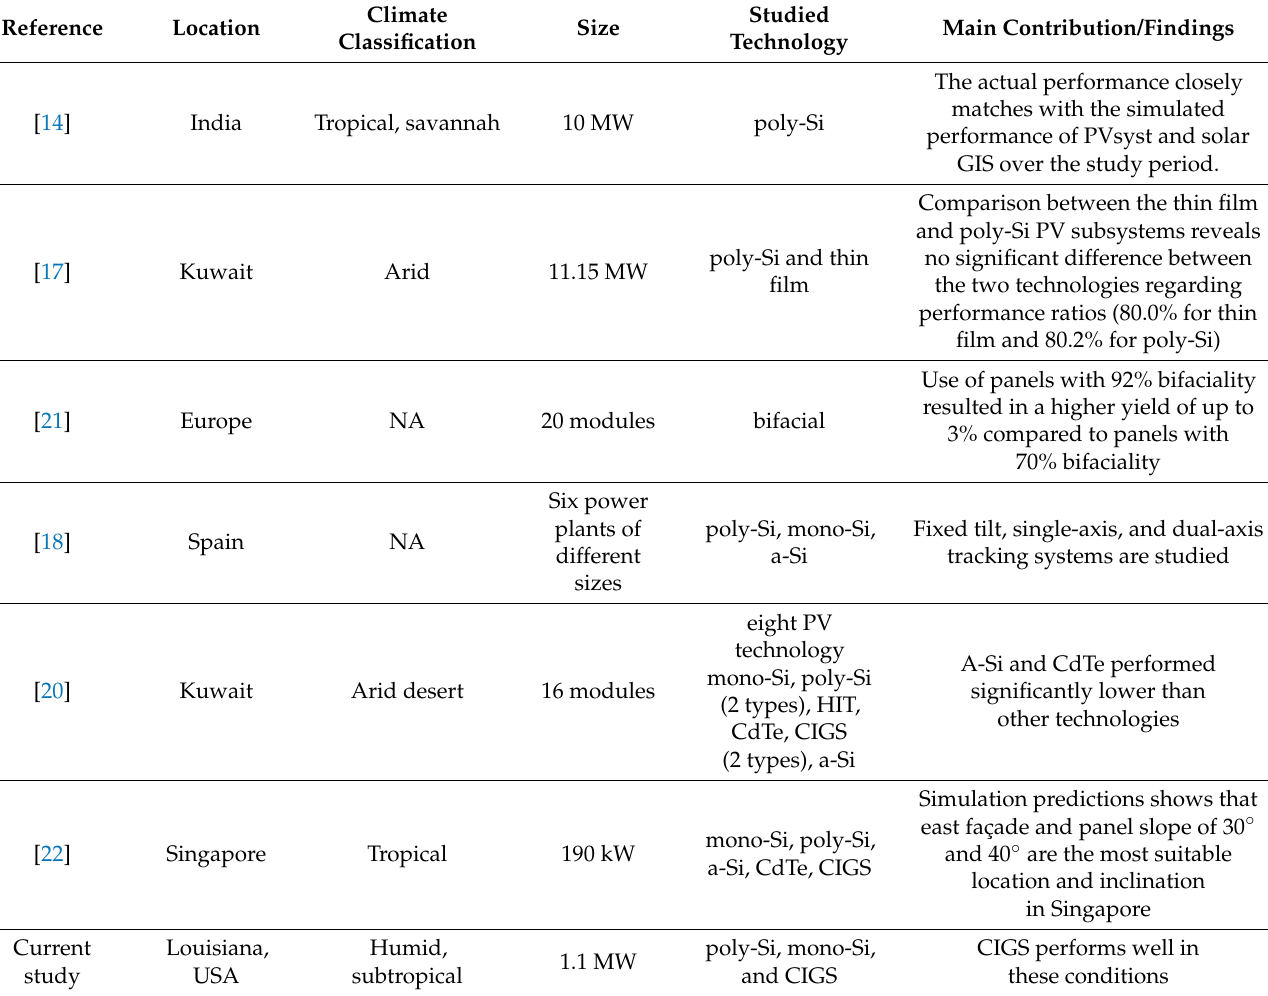
Table 1. Main findings of performance